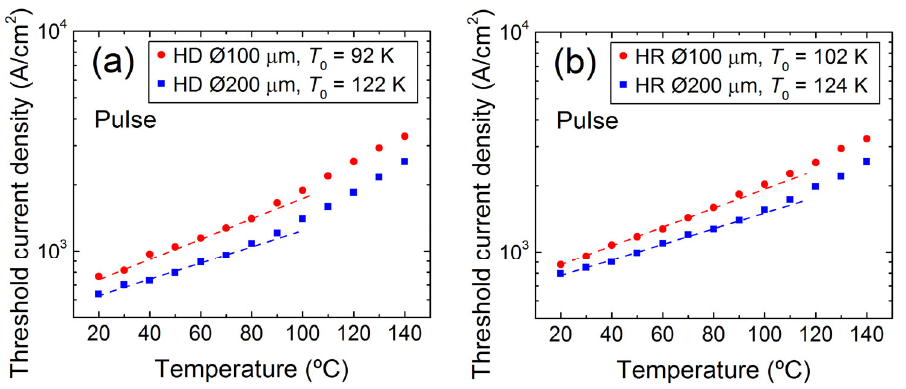
Figure 7. Temperature dependence of the threshold current density of the HD ( a ) and HR ( b ) lasers of 100 and 200 μ m in diameter in pulsed pumping mode. of 100 and 200 µ m in diameter in pulsed pumping mode.